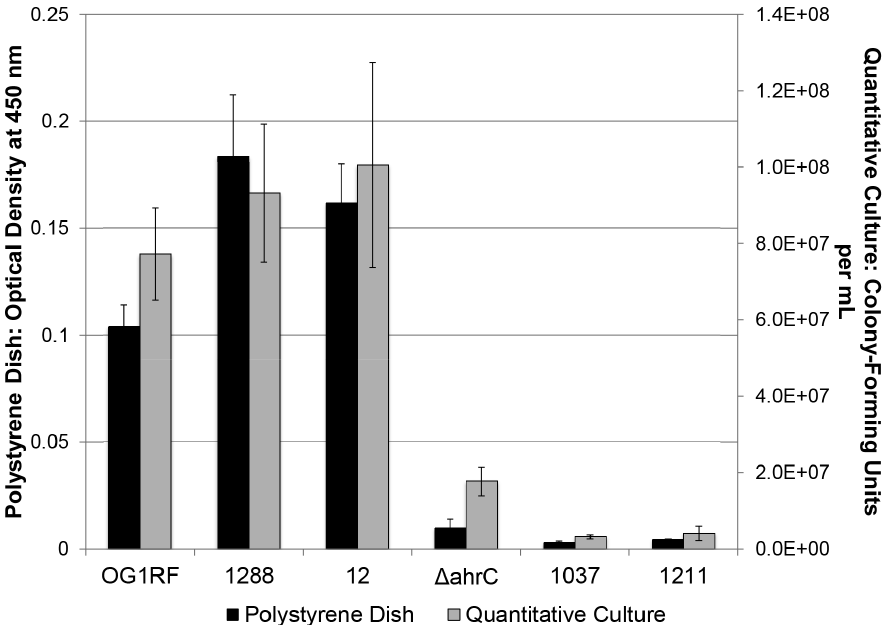
Figure 2. Comparison of safranin staining and quantitative colony-forming unit (CFU) counts using a polystyrene dish assay. Clinical Enterococcus faecalis isolates were examined for biofilm forming ability by staining for adherent biofilm biomass in a 96-well polystyrene dish biofilm assay using TSB without glucose after a 24-hour incubation. The microtiter wells were then scraped to measure CFUs present in the biofilms using quantitative culture. Error bars represent standard deviation. r 2 =0.95, p , 0.001.